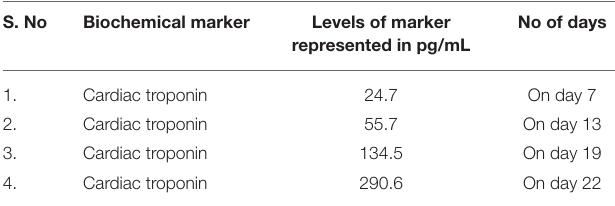
TABLE 1 | Variations in the level of cardiac troponin in non-survived patients with MI (54). S.